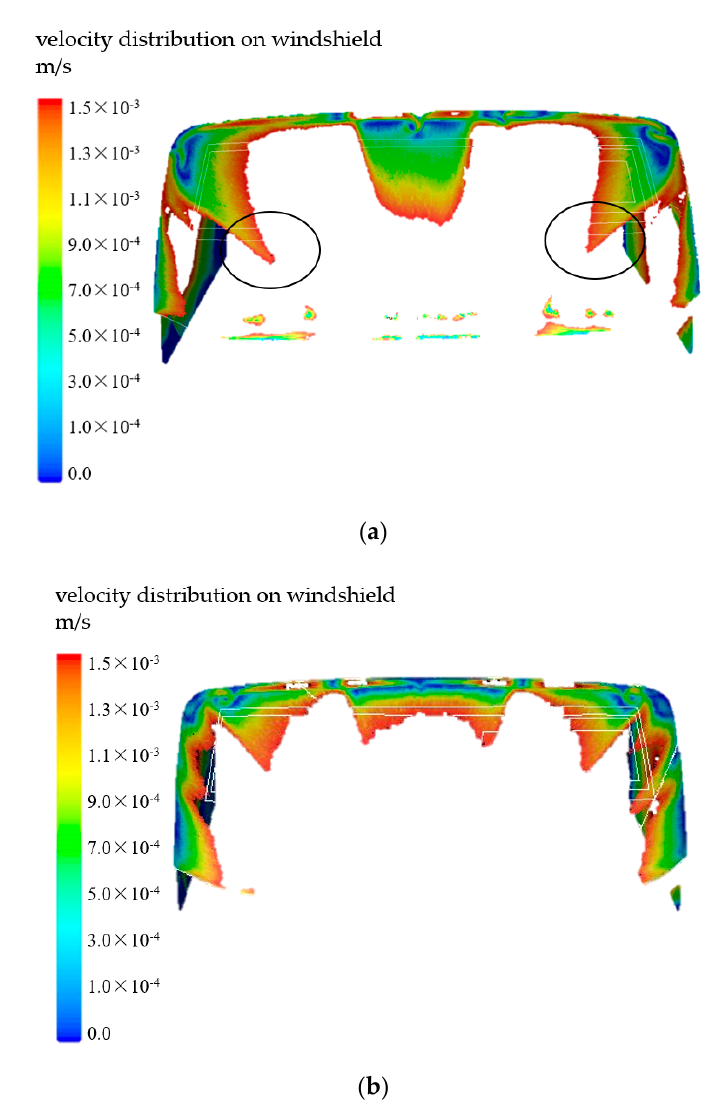
Figure 11. Velocity distribution on the windshield surface at 25 min: ( a ) Original model; ( b ) optimized model.